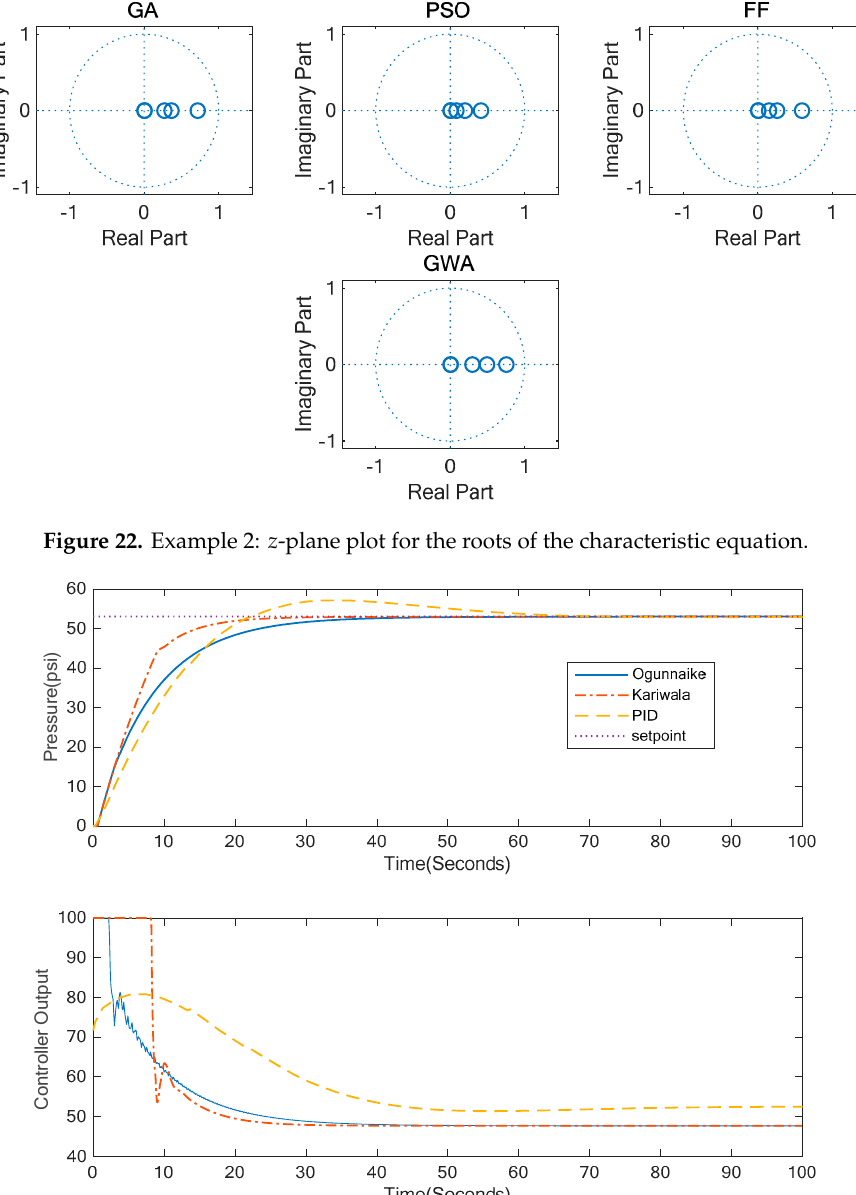
Figure 24. Comparison of the servo response for the pressure control station with optimization algorithms. The regulatory response of the pressure control process without optimally tuned values and with optimally tuned values is shown in Figures 25 and 26 respectively. The setpoint 50 psi was considered in the investigation of disturbance rejection ability. The 10% of setpoint was applied as the disturbance to the process at 50 s in Figure 25 and at 25 s in Figure 26. The disturbance rejection ability of the optimally tuned RTD-A controller was better than the other method.